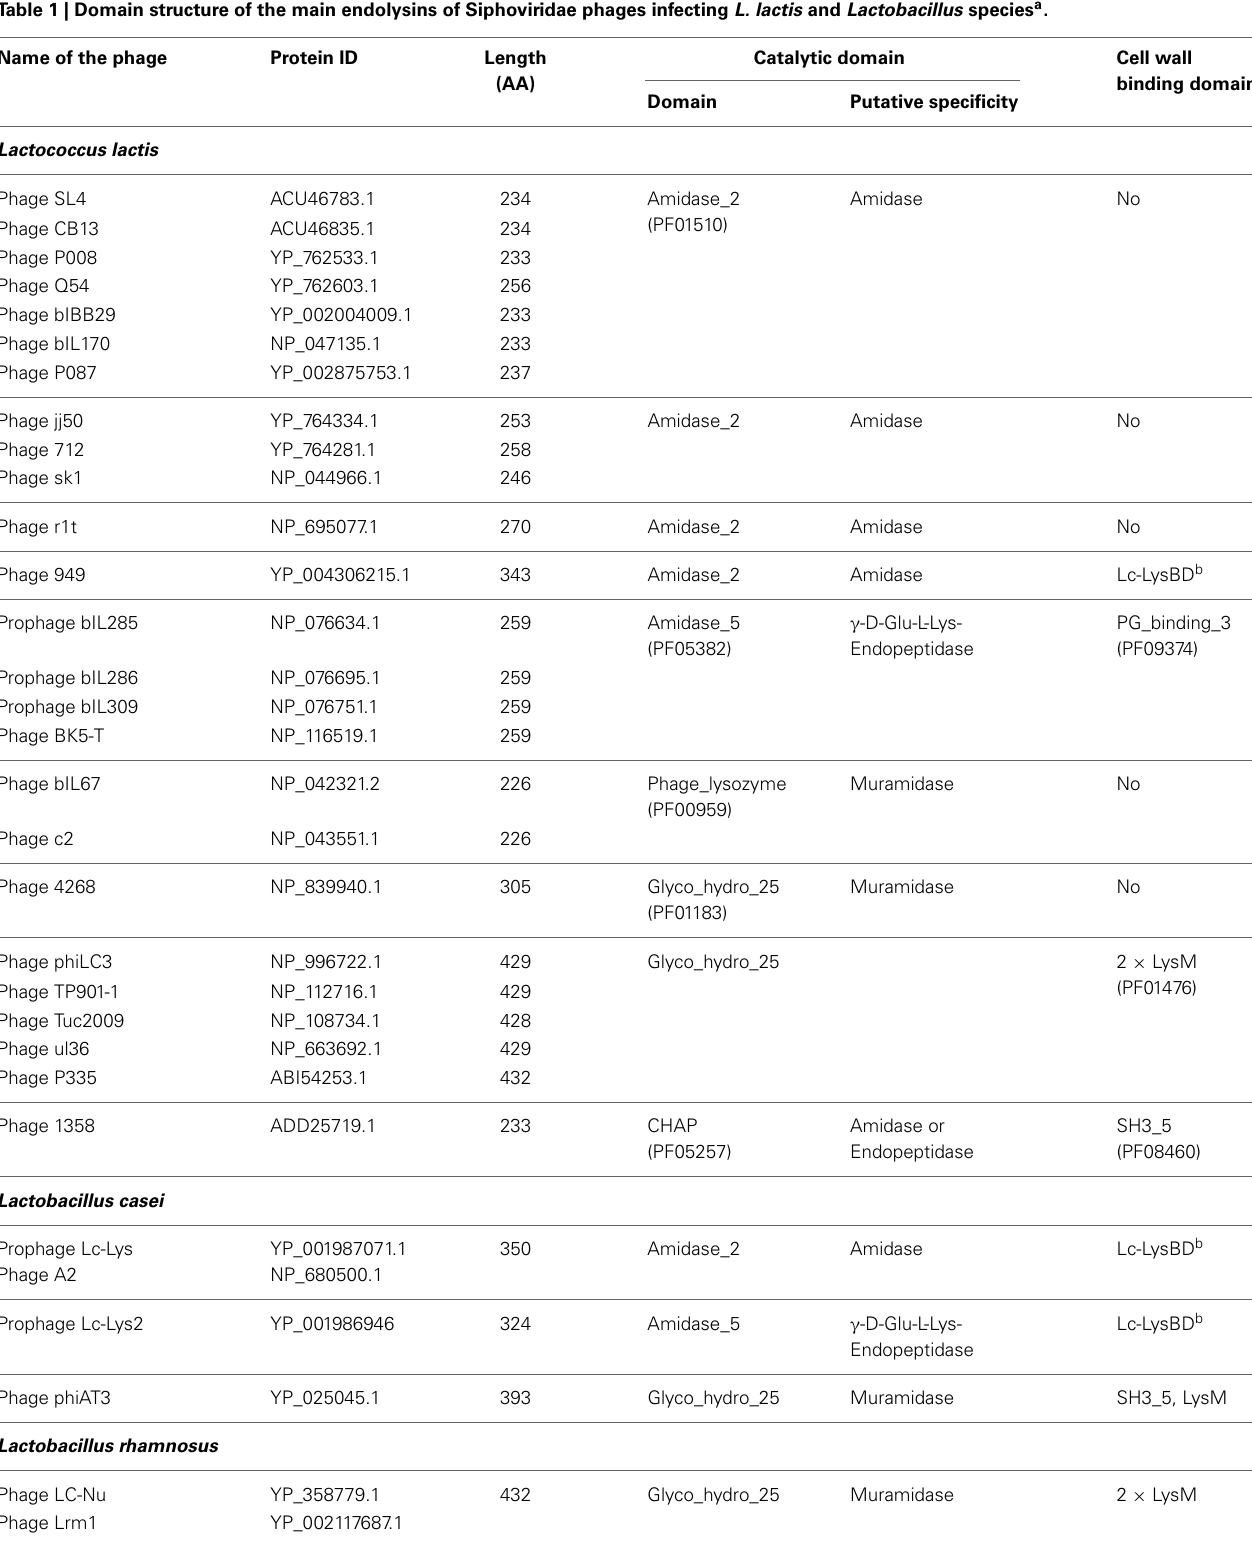
Table 1 | Domain structure of the main endolysins of Siphoviridae phages infecting L. lactis and Lactobacillus species a